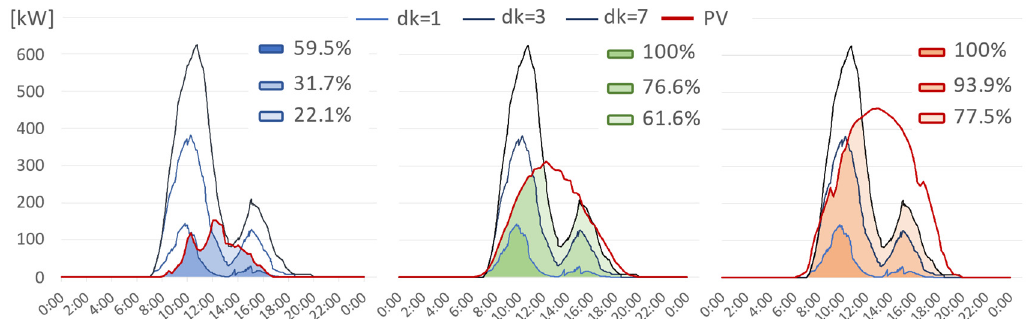
Figure 10. Comparison of the self-consumptions: the red curves are the PV power, the blue curves are the P EVs with d k = [1;3;7], and the percentage value in the legend shows the η SC in: worst condition ( blue areas , left plot ); mean condition ( green areas , center plot ); best condition ( orange areas , right plot ).